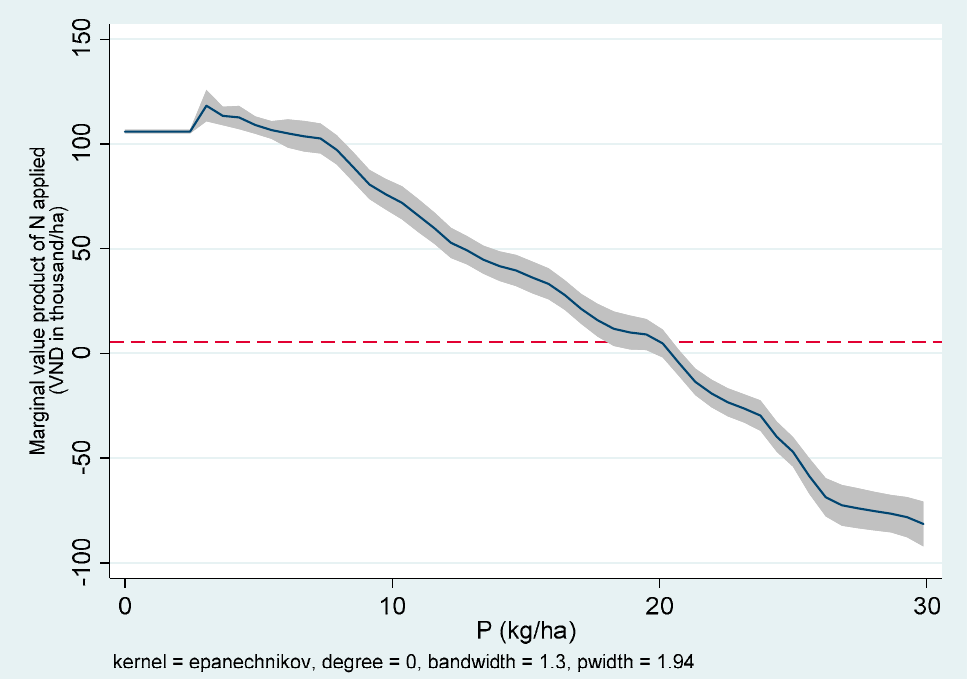
Figure 8. Marginal value product of N ( MVP N ) and P applied in Can Tho,